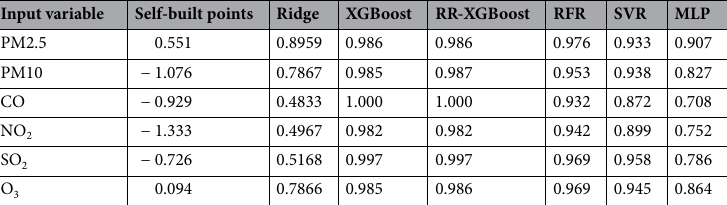
Table 7. R 2 of six types of air pollutant concentrations between self-built points, model forecast values and national control point.